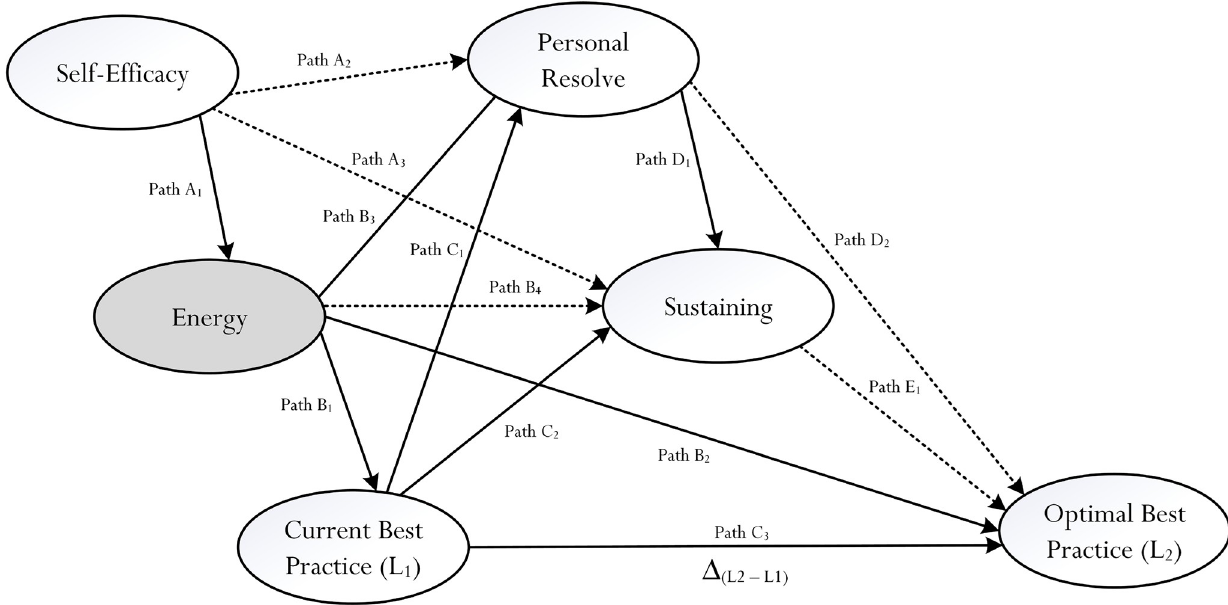
Fig 2. Conceptual model for investigation. Proposed conceptual model for statistical testing, which consists of a number of structural pathways (i.e., Path A 1 –Path E 1 ). According to Phan, Ngu, and Yeung (2019), successful experience of optimal best, L 2 , correspondingly associates with what is termed as ‘ Δ (L2 –L1) ’ (i.e., a ‘quantitative’ and/or ‘qualitative’ experience between current best practice and optimal best practice. The major paths for statistical testing and empirical validation are depicted as solid black arrows (e.g., Path A 1 , Path B 1 , etc.), whereas the minor, or lesser significant, paths are depicted as dotted black arrows (e.g., Path A 2 , Path A 3 ,